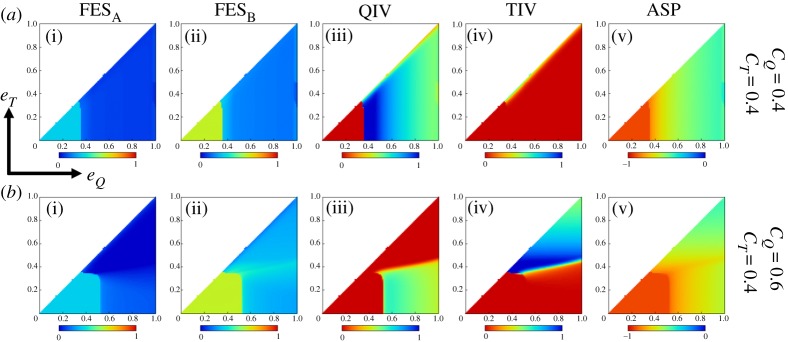
eQ versus eT (eT ≤ eQ) 2D-heatmaps with similar (upper panels) and different (lower panels) cost levels presuming mean-field framework with parameters choices, βA = βB = 0.5, γA = γB = 0.2, and initial conditions, IA(0) = 0.00001, IB(0) = 0.00002. Similar cost encourages people (with a higher degree) to commit QIV vaccine, consequently, showing sensitivity in the direction of eQ. However, in case of different costs (CQ > CT), QIV vaccine is seen to favour over TIV vaccine when eQ ≥ 0.5 (approximately), on the other hand, TIV is favoured over QIV when eT ≥ 0.4 (approximately). The average social payoff for similar cost seems to be better than that of the different costs. Moreover, infection due to influenza A is lower than influenza B. (Online version in colour.)